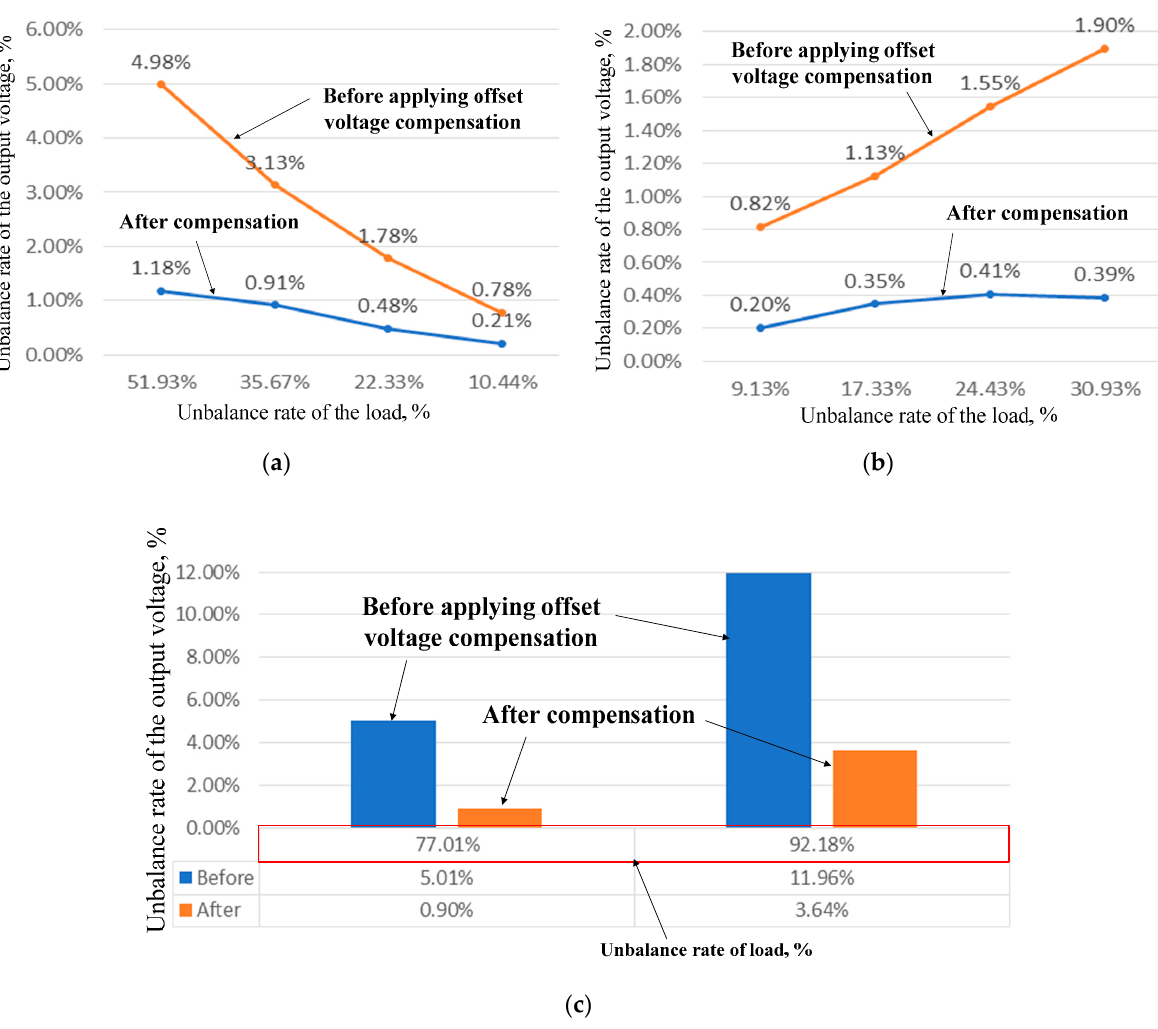
Figure 11. Voltage imbalance rate according to the unbalanced load conditions: ( a ) s-phase load is greater than r -, t -phase; ( b ) s -phase load is smaller than r -, t -phase; ( c ) under extreme unbalanced load conditions.